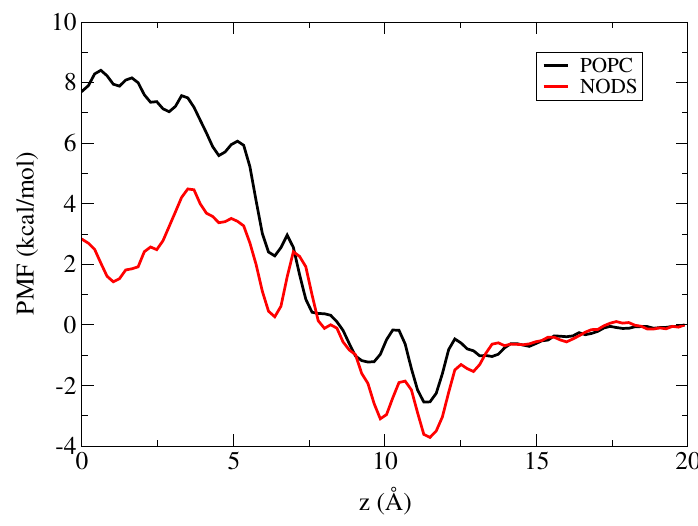
Figure 5. Potential of mean force (PMF) profiles of a K + ion along the gA channel axis, z